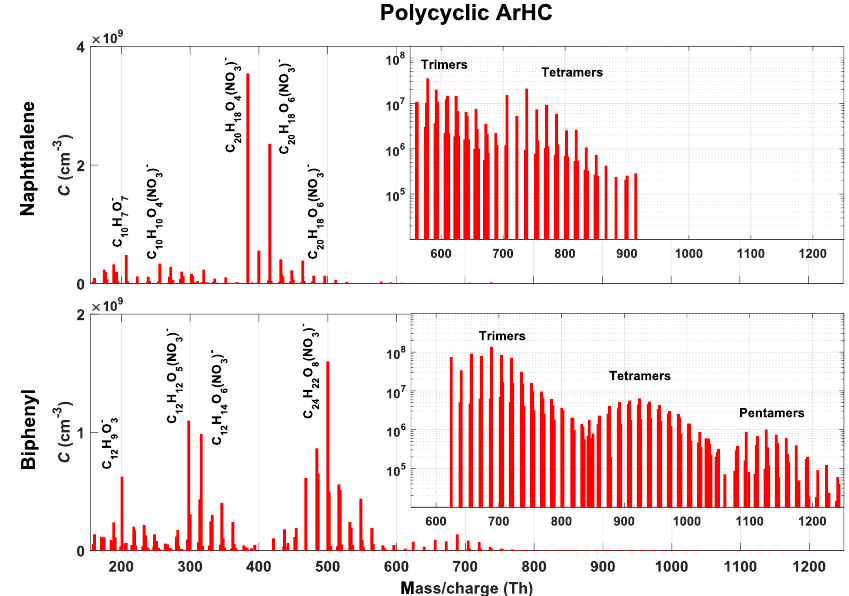
Figure 3. Mass spectra of HOMs from the bicyclic ArHCs naphthalene and biphenyl. The chemical composition of some representative peaks is displayed. Due to the high concentrations, the nitrate CI-APi-TOF was also able to detect the HOMs clusters up to the pentamer and also retrieve their chemical formula (see